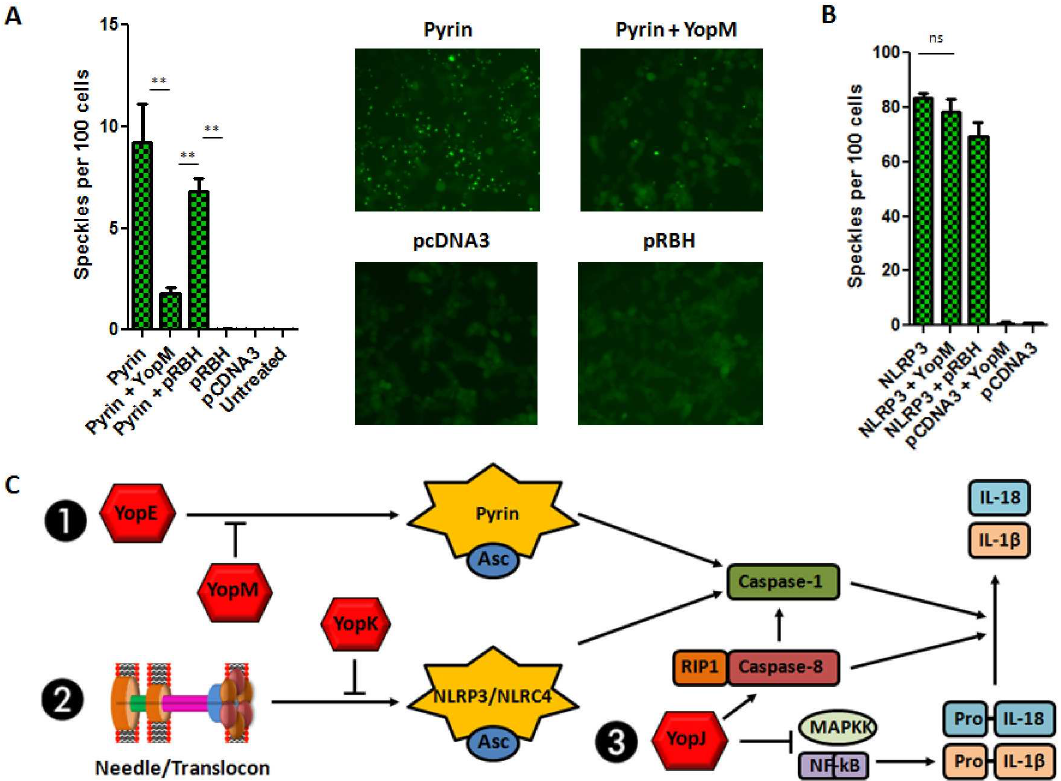
Fig 6. YopM prevents the formation of Pyrin-dependent but not NLRP3-dependent Asc complexes. A) HEK293T cells stably expressingAsc-YFP were transfected with pCDNA3-Pyrin, pRBH-YopM, or both constructs together. B) pCDNA3-NLRP3 and respectiveempty vectors were used as positive and negativecontrols. Asc speckleswere visualized, quantified,and normalized to cell number. Figures are representative of three or more experiments. Shownis mean plus